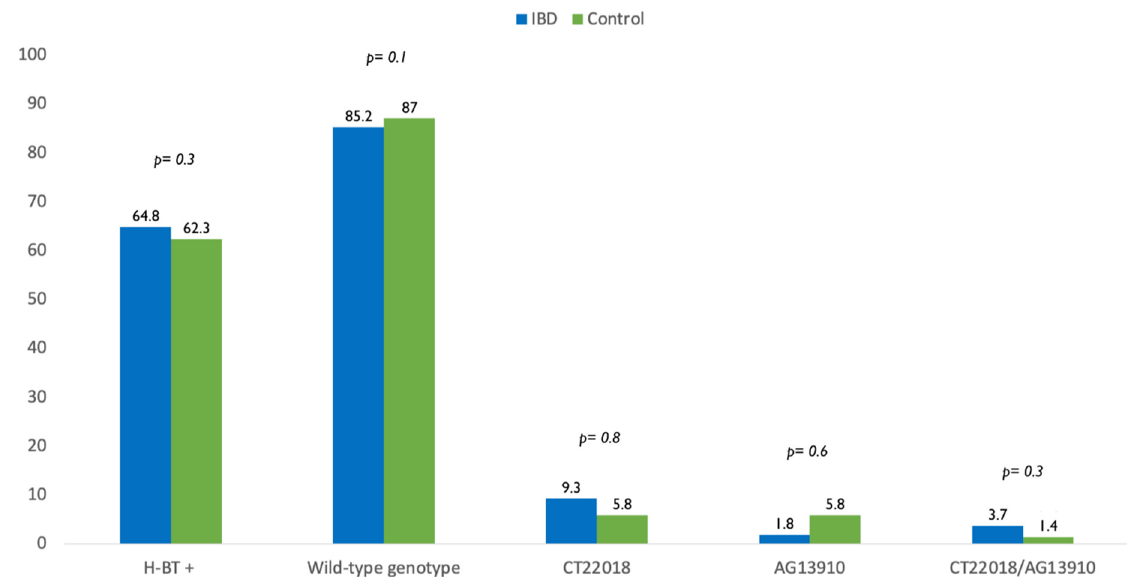
Figure 1. Difference in prevalence of positive breath test (H-BT +) and distribution of genotypes in inflammatory bowel disease (IBD) patients and control.